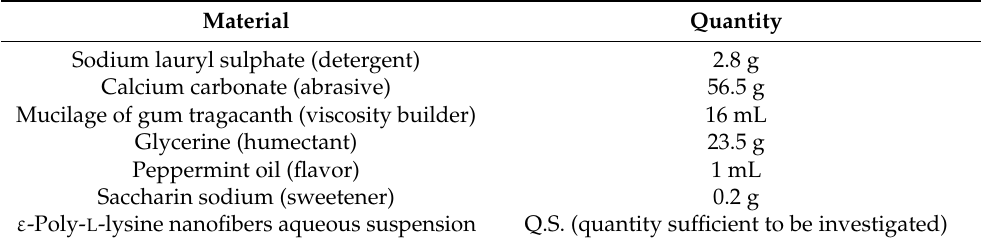
Table 1. A suggested ε -poly- L -lysine nanofibers-enriched toothpaste formulation to combat SARS- CoV-2